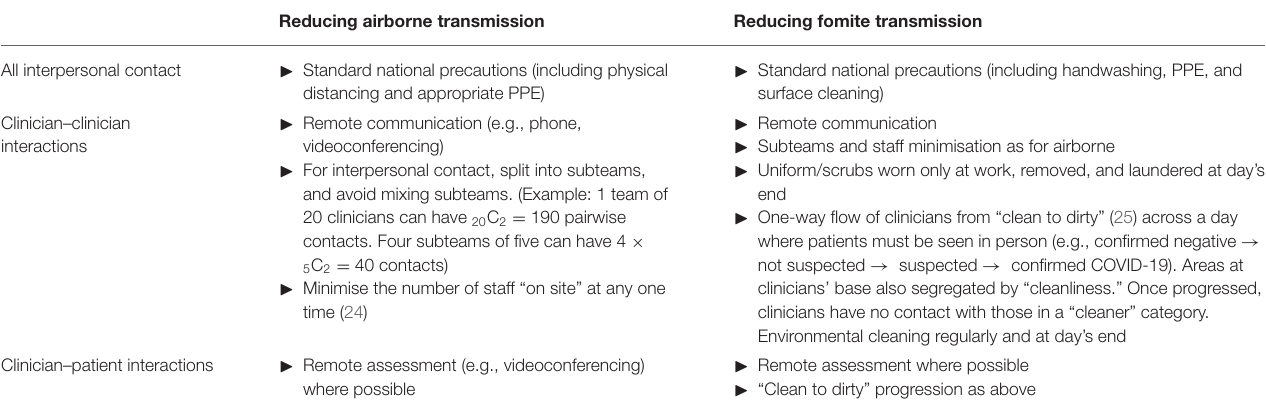
TABLE 2 | Some behavioural infection control strategies for clinical teams. Reducing airborne transmission Reducing fomite